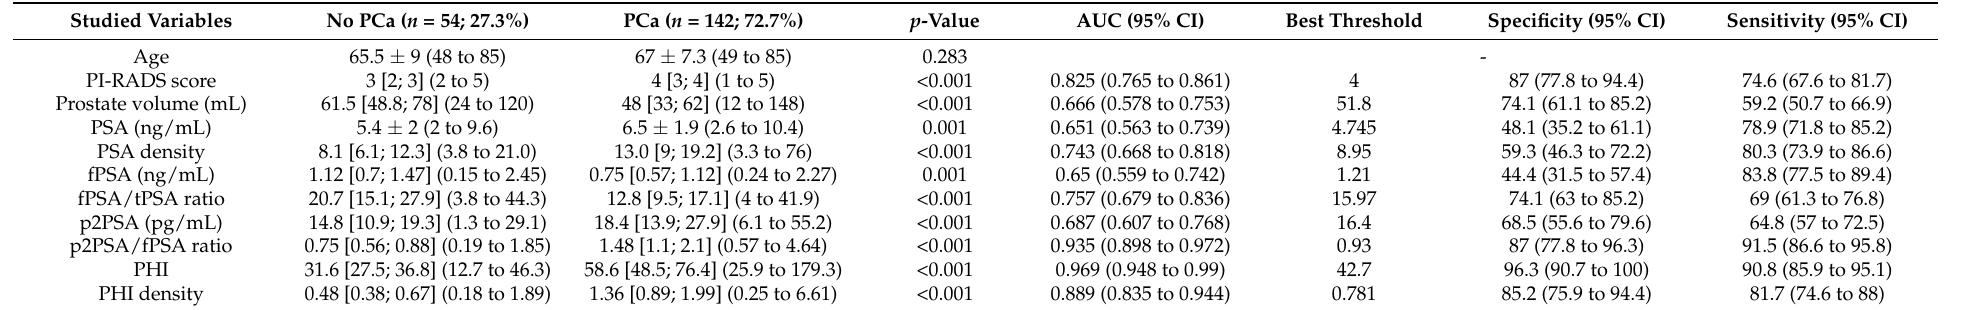
Table 2. Demographic and clinical characteristics of the study population stratified by diagnosis of PCa at biopsy. For each variable, the AUC of the corresponding ROC curve with the 95% confidence interval (CI) is shown. Best threshold for the diagnosis of PCa, according to the maximization of the Youden index, is reported with the accomplished sensitivity and specificity. Cases are defined as subjects with values equal to or greater than threshold, except for prostate volume where the opposite applies. Studied Variables